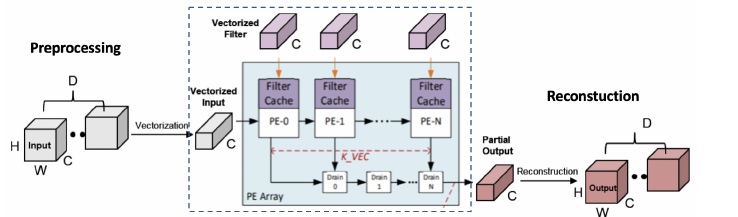
Figure 4: Vectorization process of 3D convolution primitive in custom